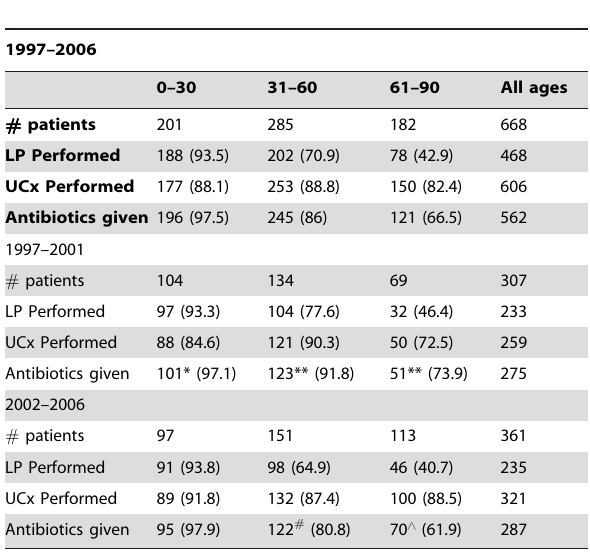
Table 5. Management of Infants with FWLS in Early and Later